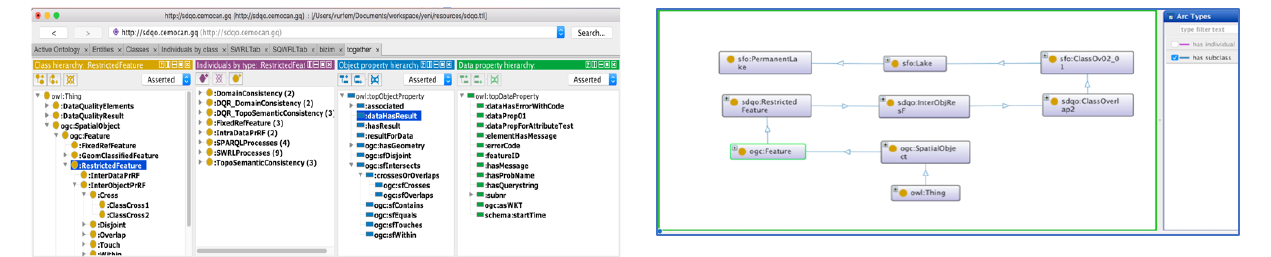
Figure 6. SDQO in Protégé ontology editor.